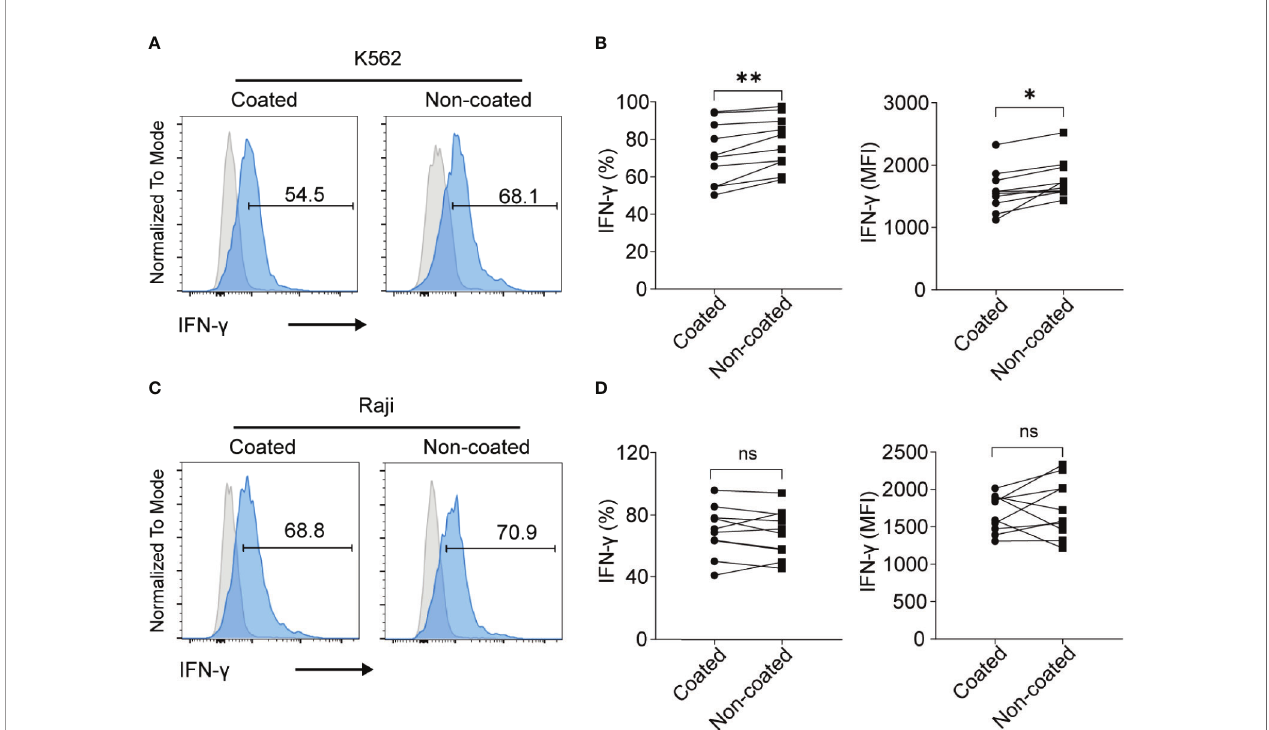
FIGURE 5 | NK cells expanded with non-coated rituximab had a stronger IFN- g secretion ability. After expansion for 14 d, the secretion of IFN- g by NK cells was assayed. (A, C) Flow cytometry analysis of IFN- g + NK cells induced with coated or non-coated rituximab from one representative donor. NK cells were incubated with K562 cells or Raji cells for 4 h, followed by IFN- g staining. (B, D) Quanti fi cation of IFN- g + NK cells activated with coated or non-coated rituximab. n = 10 donors, ns, not signi fi cant p > 0.05, * p < 0.05, ** p < 0.01; two-tailed paired